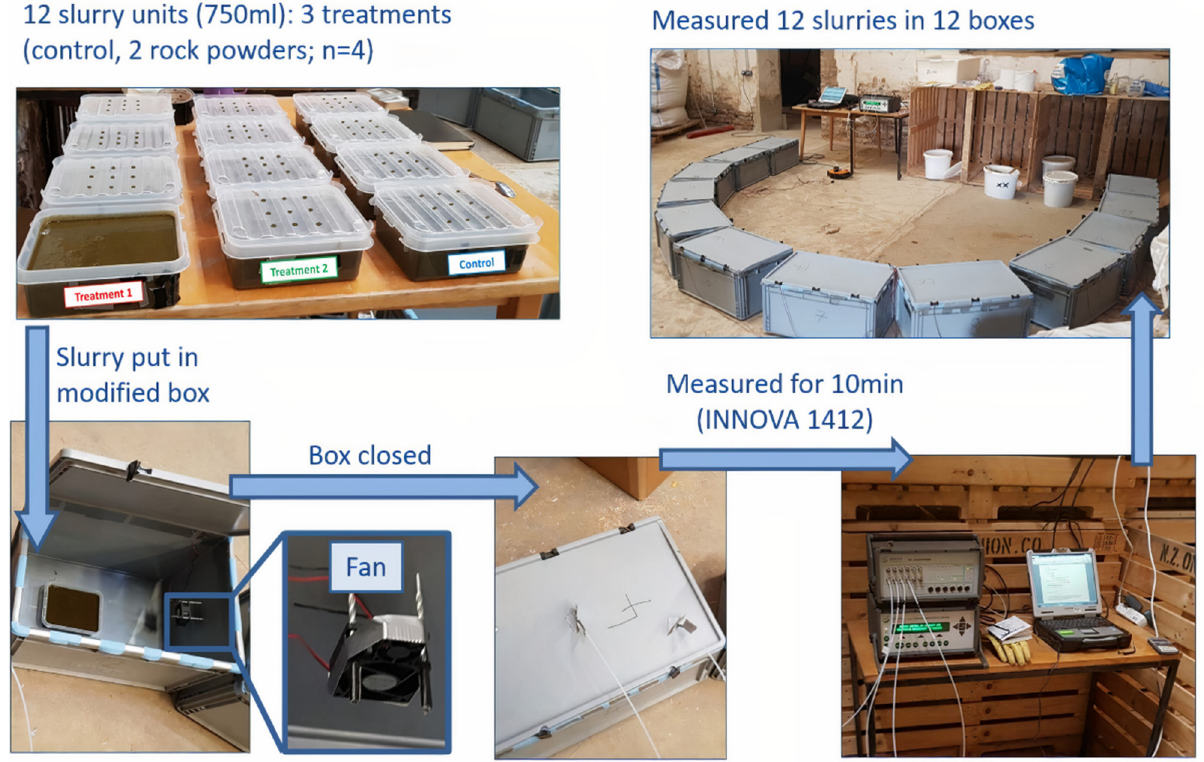
Figure 1. Measurement design: The lid (perforation accentuated) was removed from the slurry vessel, which was then put into a box with a fan and measured for 10 min with the INNOVA 1412a. After a 5-min break, in which the INNOVA attained background air concentration again, the next slurry vessel was measured in the next box. All 12 slurries were measured in a separate box according to this procedure.